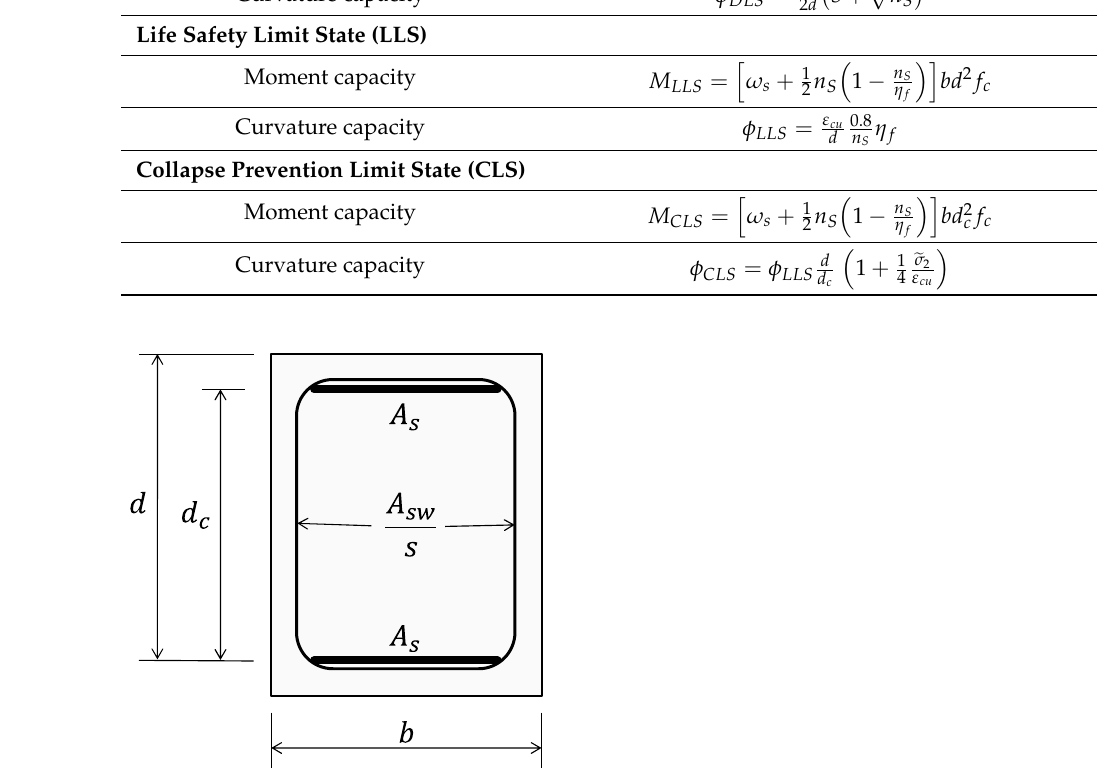
Figure 1. Moment-curvature relationship of a column section with the corresponding Limit State criteria for Damage lim- itation Limit State (DLS, tension steel yielding), Life safety Limit State (LLS, concrete cover crushing), and Collapse pre- vention Limit State (CLS, concrete core crushing).